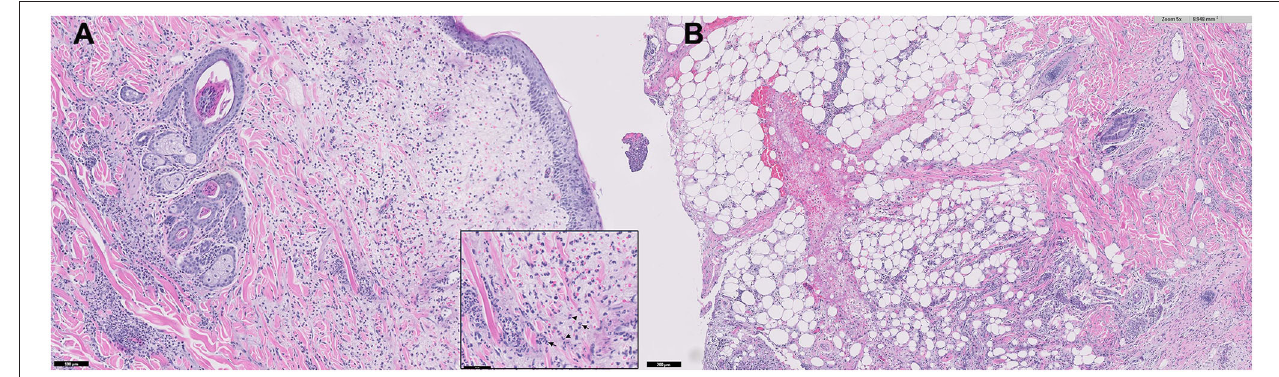
FIGURE 4 | Microphotograph of a skin biopsy. Remarkable infiltration of neutrophils (arrows) from the superficial to deep dermis (A) and also multifocally extending to the subcutaneous tissue (B) .